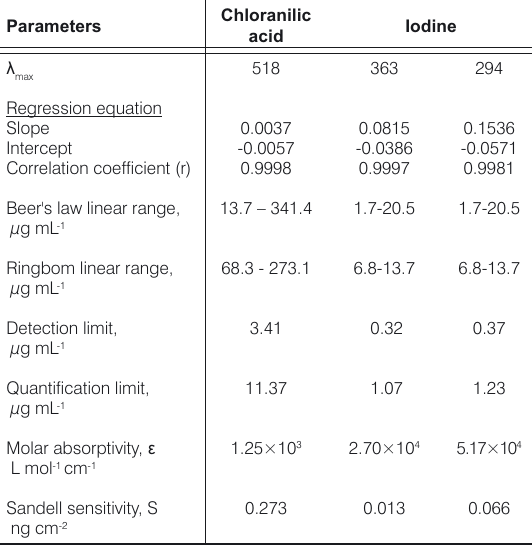
Table 2. Spectral data for the reaction of sulpiride with p-chloranilic acid and iodine.